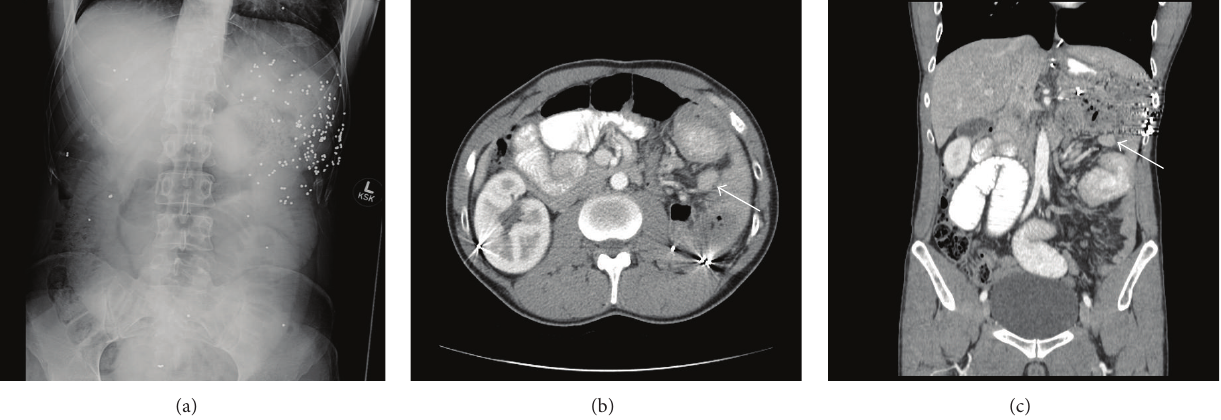
Figure 1: Abdominal X-ray shown in (a), depicting the number of shrapnel left in the left side of the body after the gunshot injury, in addition to dilated loops of bowel. CT scan with oral and intravenous contrast shows the splenosis deposit (white arrow) in axial (b) and coronal (c) views.